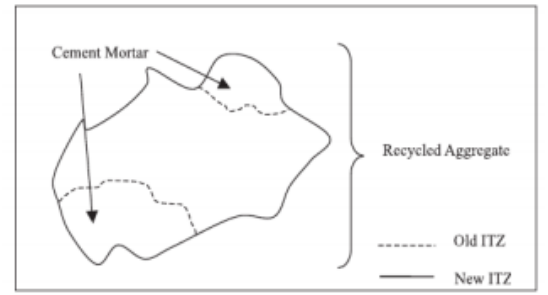
Figure 1. Recycled aggregate configuration